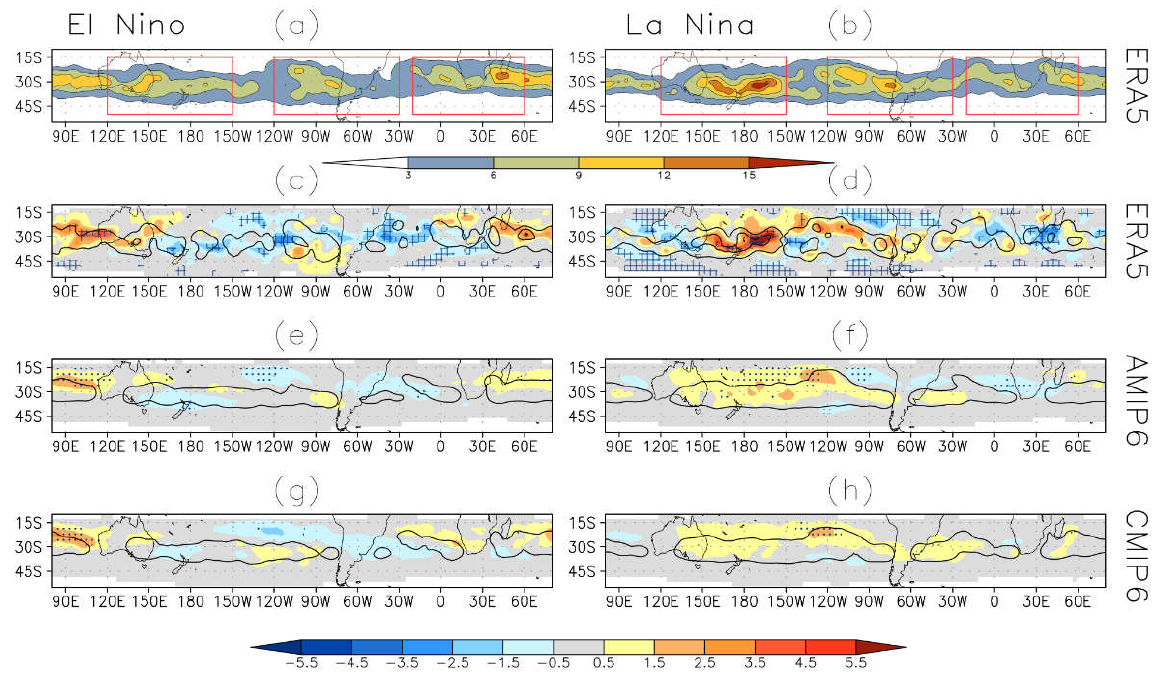
Figure 4. Same as Figure 1 but for the Southern Hemisphere.